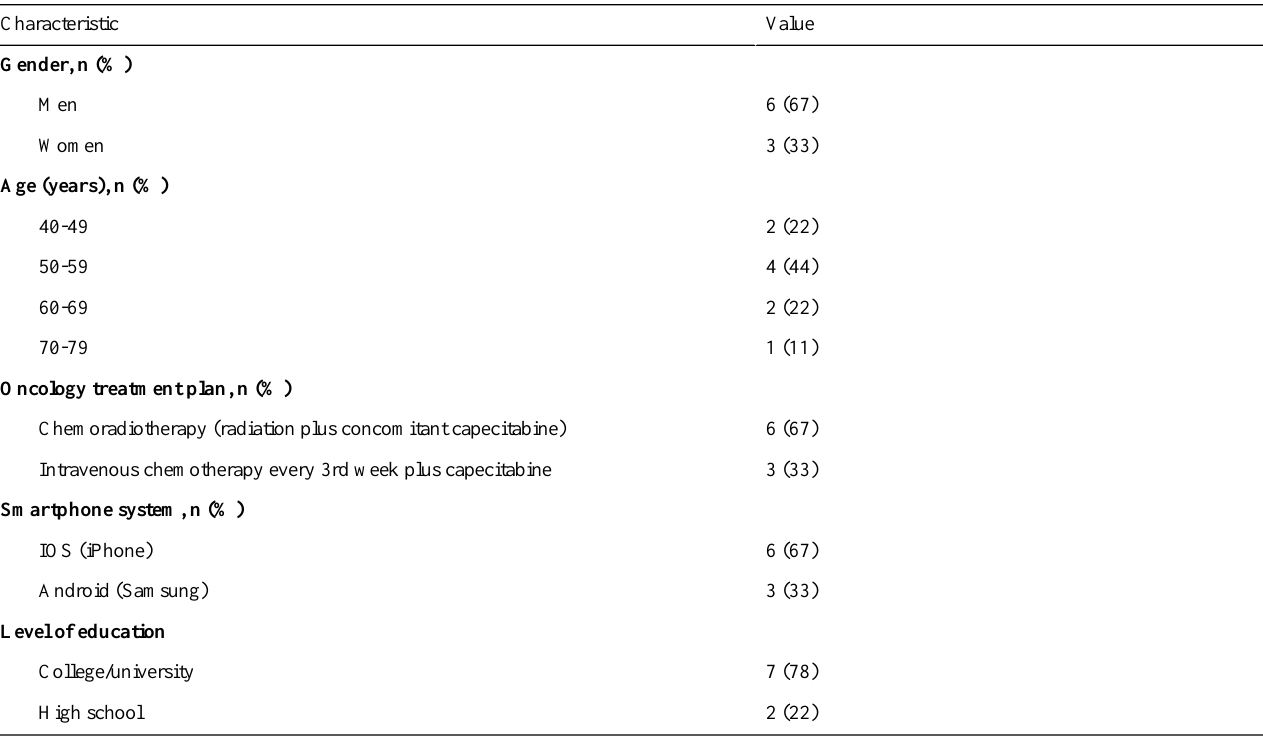
Table 1. Demographic and treatment characteristics of the patients in this study